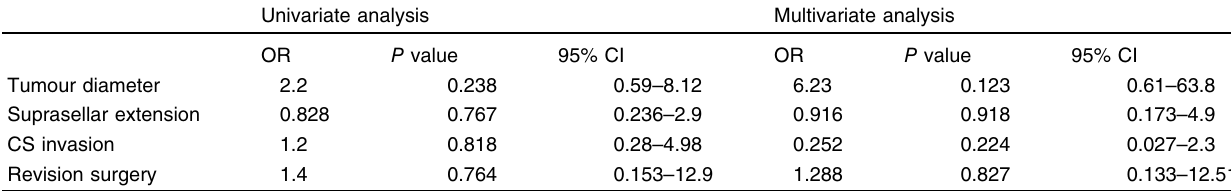
Table 8 Preoperative predictors for development of postoperative complications in 65 pituitary adenoma patients Univariate